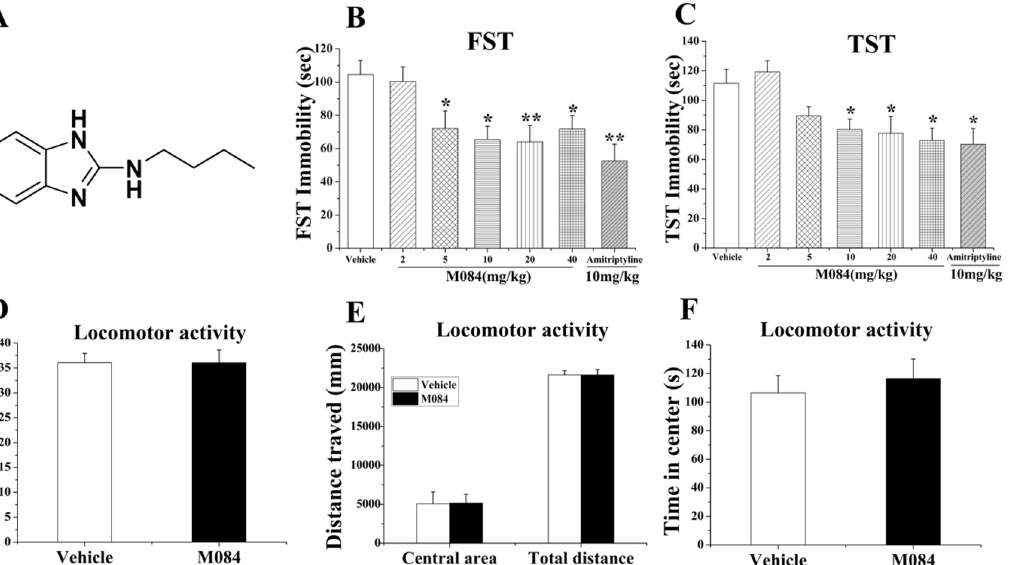
Fig 1. M084 exhibits antidepressant-like effects in mice. (A) The chemical structure of M084. (B&C) M084 reduced immobility time in forced swim test (FST, B) and tail suspension test (TST, C). Amitriptyline, a known antidepressant, was used as a positive control (10 mg/kg, 2 hrs). (D-F) In locomotor activity test, mice treated with vehicle and M084 (10 mg/kg, 2 hrs) showed no difference over the average speed (D), distance in central area and total distance traveled (E), and time in central area (F). Results are presented as mean ± SEM. N = 10 – 12/group, * p < 0.05, ** p <